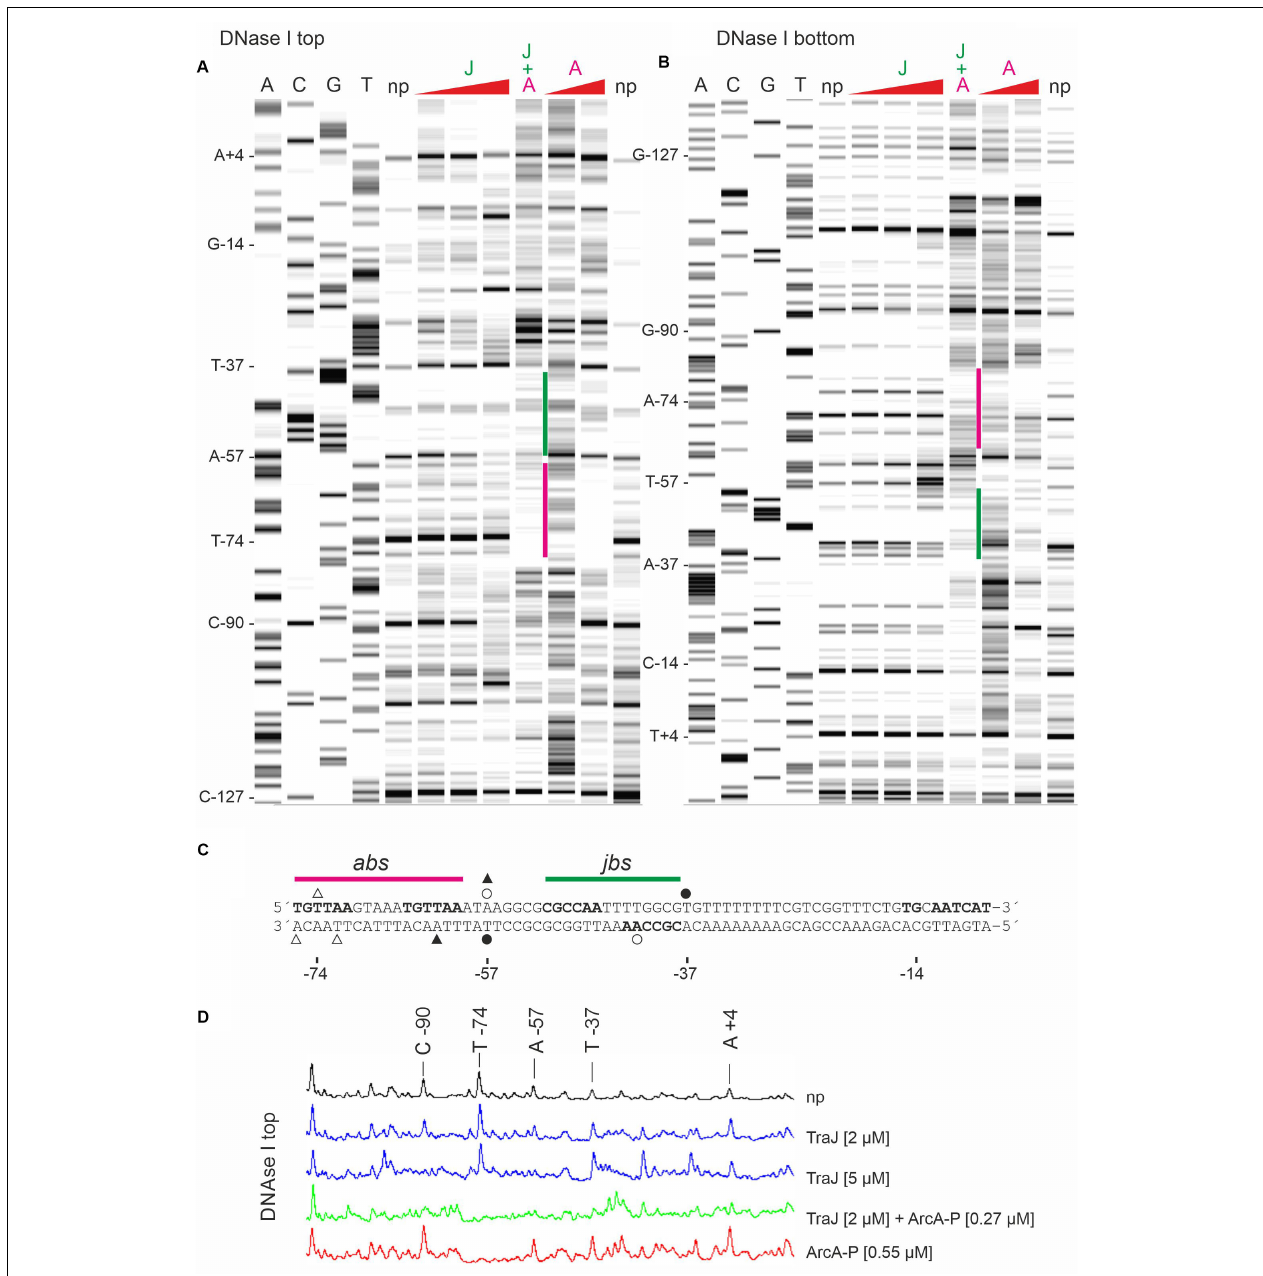
FIGURE 5 | DNase I protection pattern by TraJ R1 and ArcA-P obtained on R1P Y DNA. R1P Y DNA fluorescently 5 (cid:48) -labeled on the non-template (A) or the template (B) strand was incubated with proteins as indicated and subsequently digested with DNase I. The resulting DNA fragments were separated on a denaturing PAG. A gel-like image of the detected fluorescence signals is shown in A,B . Lanes A, C, G, and T are products of sequencing reactions. For orientation, some bases are indicated on the left side of lane A, respectively. Proteins were added before DNase I digestion as follows: J: TraJ R1 0.5, 2, or 5 µ M; A: ArcA-P 0.27 or 0.55 µ M. J + A: TraJR1 + ArcA-P, 2 and 0.27 µ M, respectively. np, no protein added before DNase I digestion. A: TraJ R1 protects from DNase I cleavage at positions A-57 and C-90. ArcA-P protects T-74. Positions A-57 and T-74 are consistent with the proposed jbs and abs recognition sites as shown in C , respectively. Addition of both proteins produces a protection pattern indicating simultaneous DNA binding of TraJ R1 (indicated by a green bar) and ArcA-P (magenta bar). (B) TraJ R1 protects from DNase I cleavage at position A-42. ArcA-P protects T-72 and A-76. These positions are consistent with the proposed jbs and abs regions as shown in C , respectively. Addition of both proteins produces a protection pattern indicating simultaneous DNA binding. (C) DNA sequences of non-template (top) and template (bottom) DNA strands from the R1P Y promoter region ( − 76 to − 7). The proposed abs ( − 76 to − 60) and jbs ( − 51 to − 38) sites are indicated above the sequence. Open triangles indicate bases protected by ArcA-P and filled triangles represent ArcA-P induced DNase I cleavage sites. Open circles indicate bases protected by TraJR1 and filled circles represent TraJ R1 induced DNase I cleavage sites. + 1: transcription start site as determined by reverse transcription of tra mRNA, − 10: − 10 region of the P Y promoter, TG: extended − 10 motif. (D) Curve view of DNase I footprinting experiment shown in A . Proteins were added as indicated. np, no protein added before DNase I treatment.